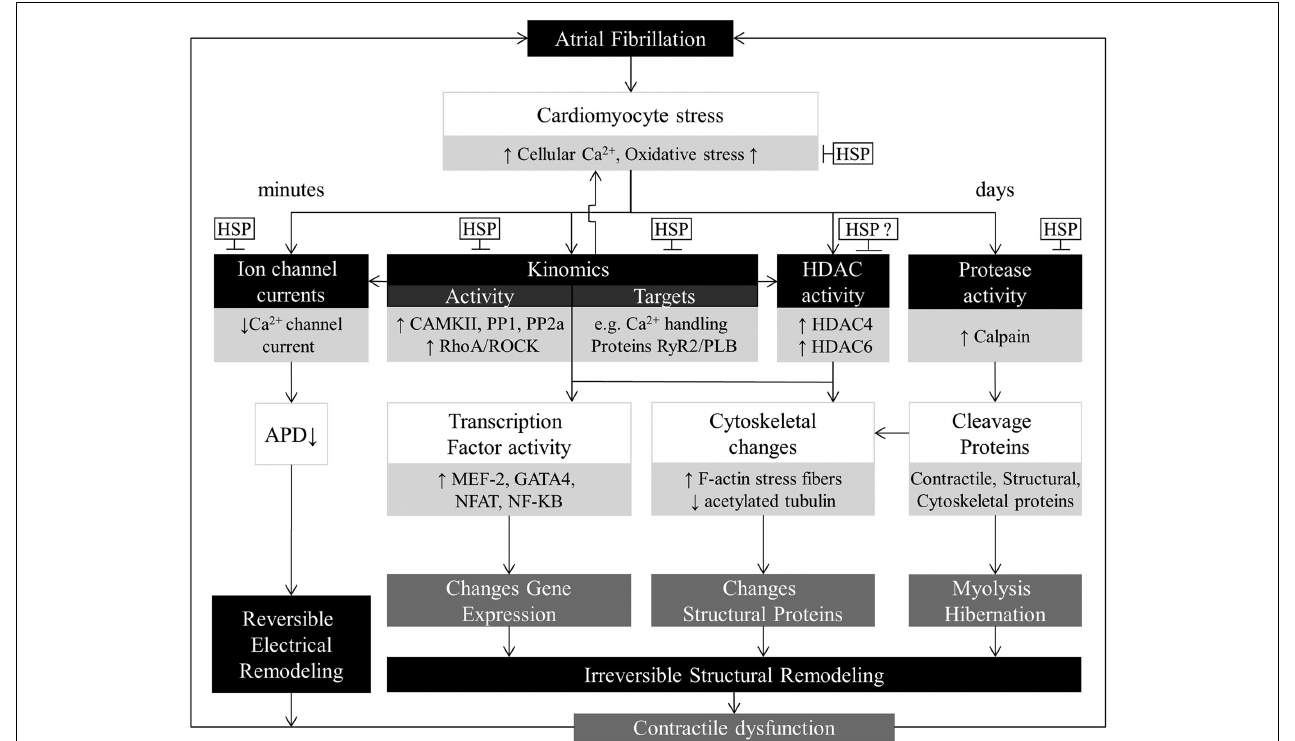
FIGURE 2 | Overview ofAF-induced derailment of cardiomyocyte proteostasis. AF induces time-related progressive myocyte remodeling. First, AF causes cellular Ca 2 + overload and oxidative stress, which results in a direct inhibition of the L-type Ca 2 + channel, shortening of action potential duration, and contractile dysfunction.These changes have an early onset and are reversible.The early processes protect the cardiomyocyte against Ca 2 + overload but at the expense of creating a substrate for persistent AF.When AF persists, derailment of proteostasis occurs via activation of calpain,